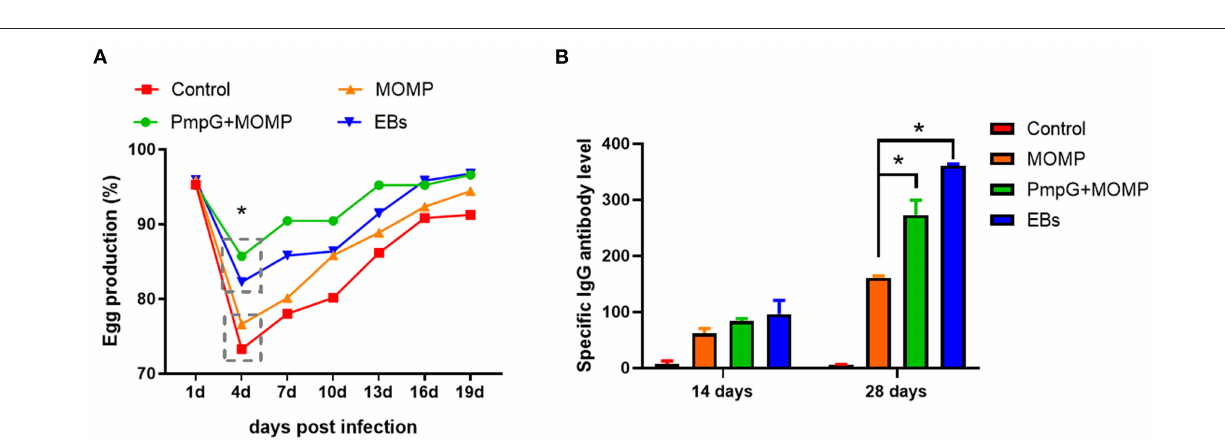
FIGURE 6 | Egg productions and specific IgG antibody level of breeder ducks. (A) Egg performance was dramatically reduced in the commercial MOMP group and the control group in comparison with the PmpGs + MOMP group and the inactivated EBs group post challenge ( p < 0.05). (B) Both the inactivated EBs group and the PmpGs + MOMP group induced higher robust IgG antibodies via intranasal route than the MOMP vaccine did via intramuscular injection on day 28 ( p < 0.05). The differences were analyzed by ANOVA (* p <